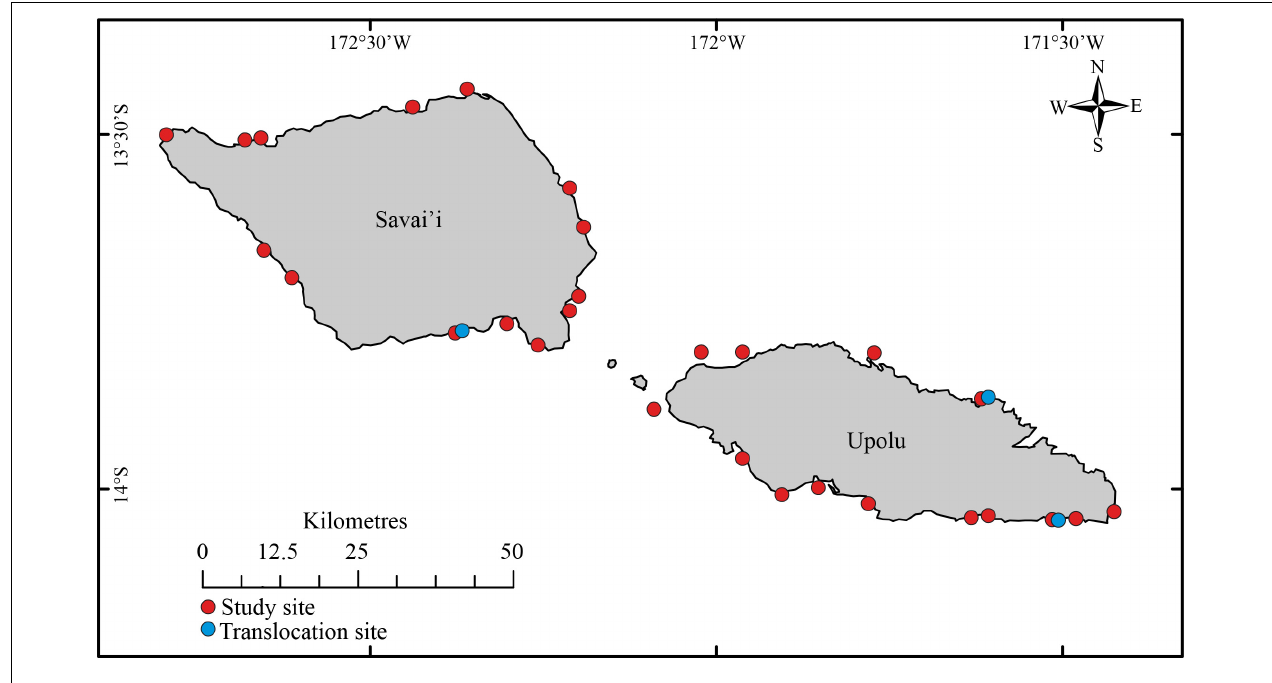
FIGURE 2 | Location of the 28 survey sites surrounding Upolu and Savai’i,